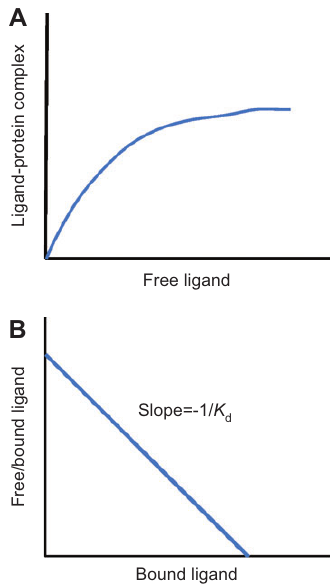
Figure 3 (A) Diagram of a hyperbolic curve showing ligand-protein complex vs. free ligand. (B) Schematic of a Scatchard plot, which plots free/bound ligand vs. free ligand.